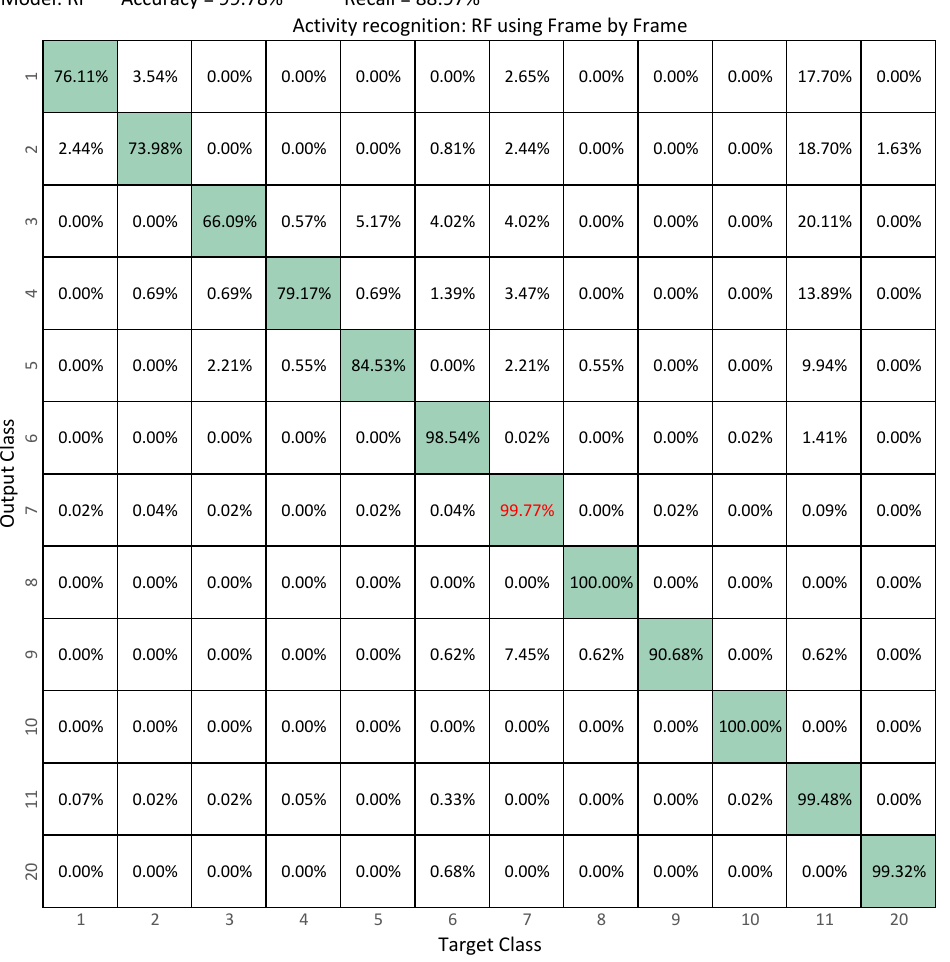
Figure 8. Confusion matrices in activity recognition: Frame-by-Frame+RF. Best results are shown in